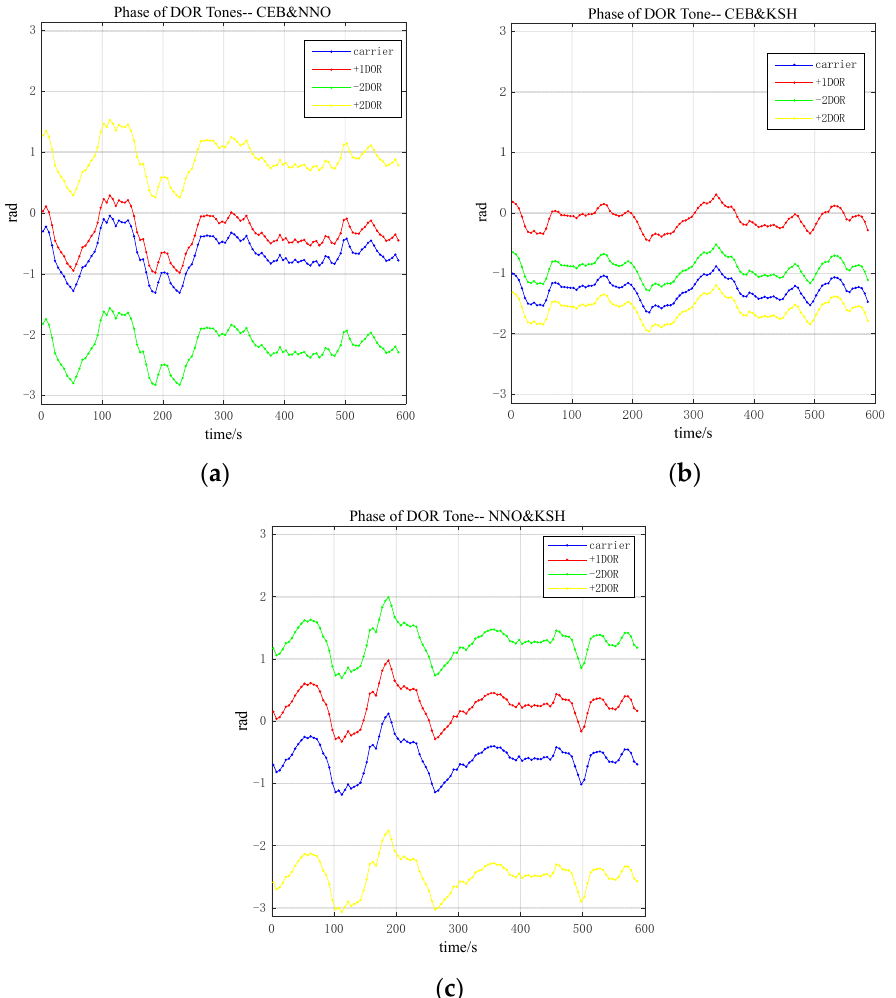
Figure 14. Phase of DOR tones signal. Fluctuation of residual phase of all tones signal could be identified, mainly caused by ionosphere fluctuation: ( a ) baseline CEB ‐ NNO; ( b ) baseline CEB ‐ KSH; ( c ) Baseline NNO ‐ KSH.